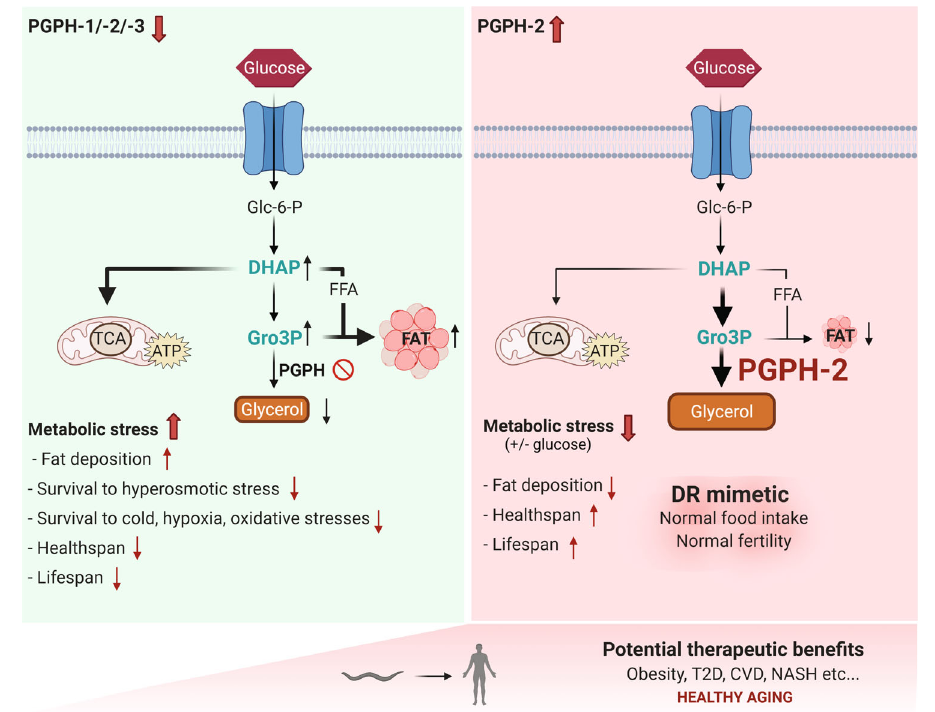
Fig. 8 Graphical abstract summarizing the main fi ndings. We have characterized the function of the PGPH enzymes in C. elegans . PGPH enzymes act as glycerol-3-phosphate phosphatase (G3PP) and are responsible for glycerol production via the direct hydrolysis of glycerol-3-phosphate. Loss of PGPH enzymes decreases resistance to diverse stresses, shortens lifespan and healthspan and exacerbates glucotoxicity. In contrast, the overexpression of PGPH-2, mimics calorie restriction without changes in food intake and fertility, decreases fat deposition, protects from glucose-induced toxicity and promotes healthy aging. Overall, the results identify G3PP as a candidate therapeutic avenue to treat obesity and age-related cardiometabolic disorders, and to promote healthy their progeny, around 15 animals were handpicked and placed on corresponding RNAi plates supplemented with 400mM NaCl for two hours. The plates were screened for reduced GFP signal and a secondary screen to con fi rm positive hits followed. Lifespan and glucose toxicity assays . All lifespan and glucose toxicity curves were performed at 20°C. Brie fl y, C. elegans nematodes were synchronized as described above. For glucose toxicity, the animals were constantly transferred to E. coli seeded agar plates supplemented with 2% glucose. Three days after egg pre-